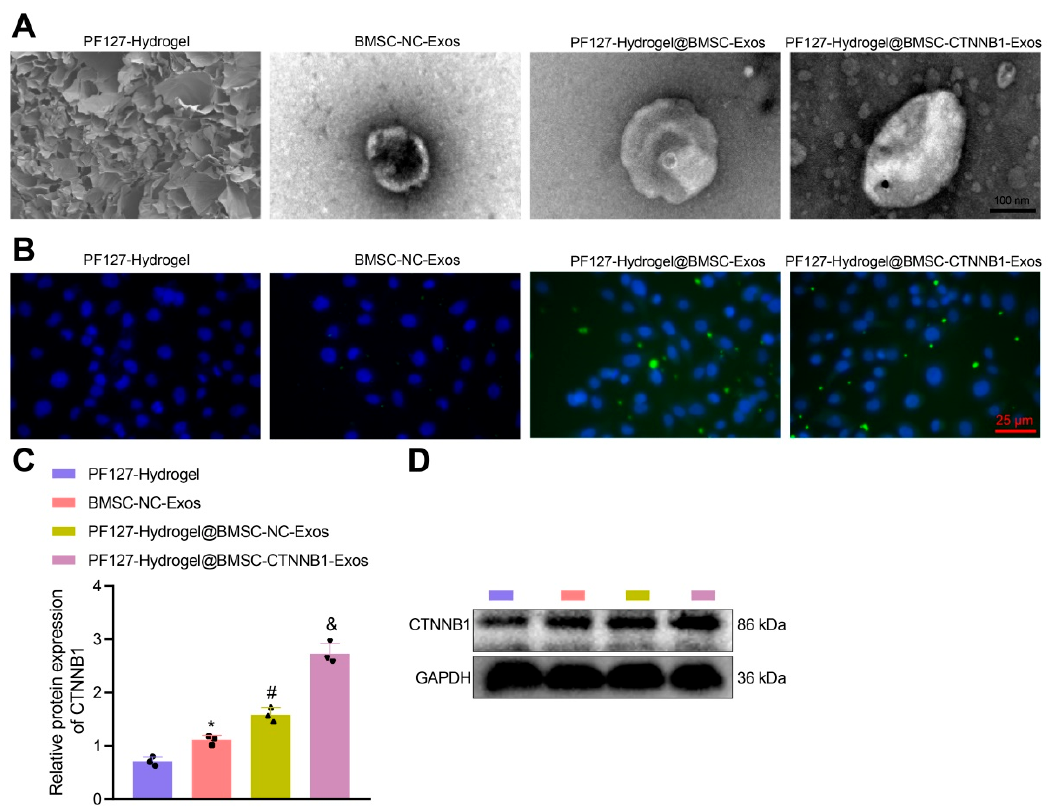
Figure 4. Assessment of uptake of PF127 hydrogel@BMSC-Exos by BMSCs. ( A ) The morphology of PF127 hydrogel, BMSC-NC-Exos, PF127 hydrogel@BMSC-Exos, and PF127 hydrogel@BMSC- CTNNB1-Exos, as observed by SEM. ( B ) The PKH67 labeling method to detect the uptake of Exos by BMSCs in response to PF127 hydrogel@BMSC-CTNNB1-Exos. ( C , D ) The protein expression of CTNNB1 in BMSCs in response to PF127 hydrogel@BMSC-CTNNB1-Exos, as determined by Western blot analysis. * p < 0.05 vs. the PF127 hydrogel group. # p < 0.05 vs. the BMSC-NC-Exos group. & p < 0.05 vs. the PF127 hydrogel@BMSC-NC-Exos group. Cell experiments were independently repeated three times.